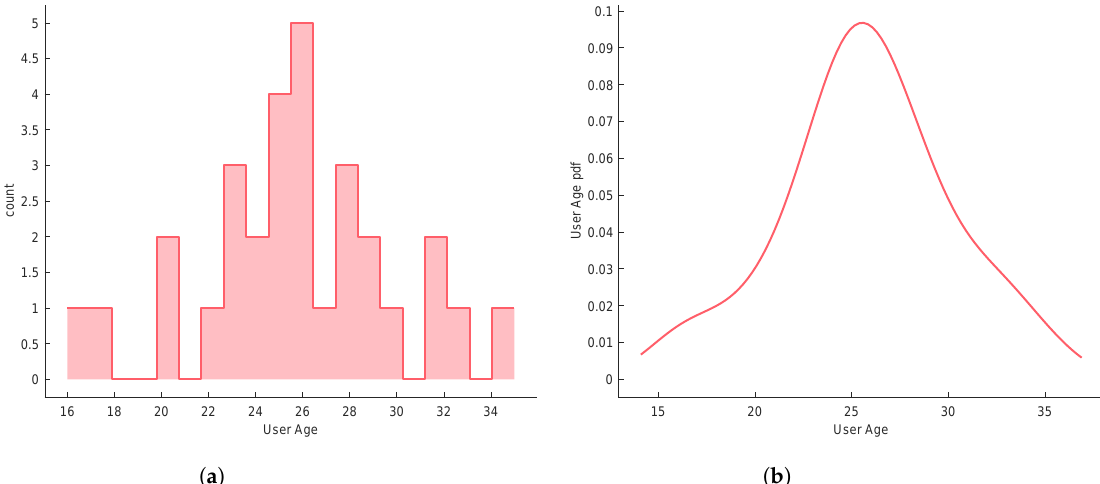
Figure 4. Users’ age characterization; ( a ) Age histogram; ( b ) Probability density function of users’